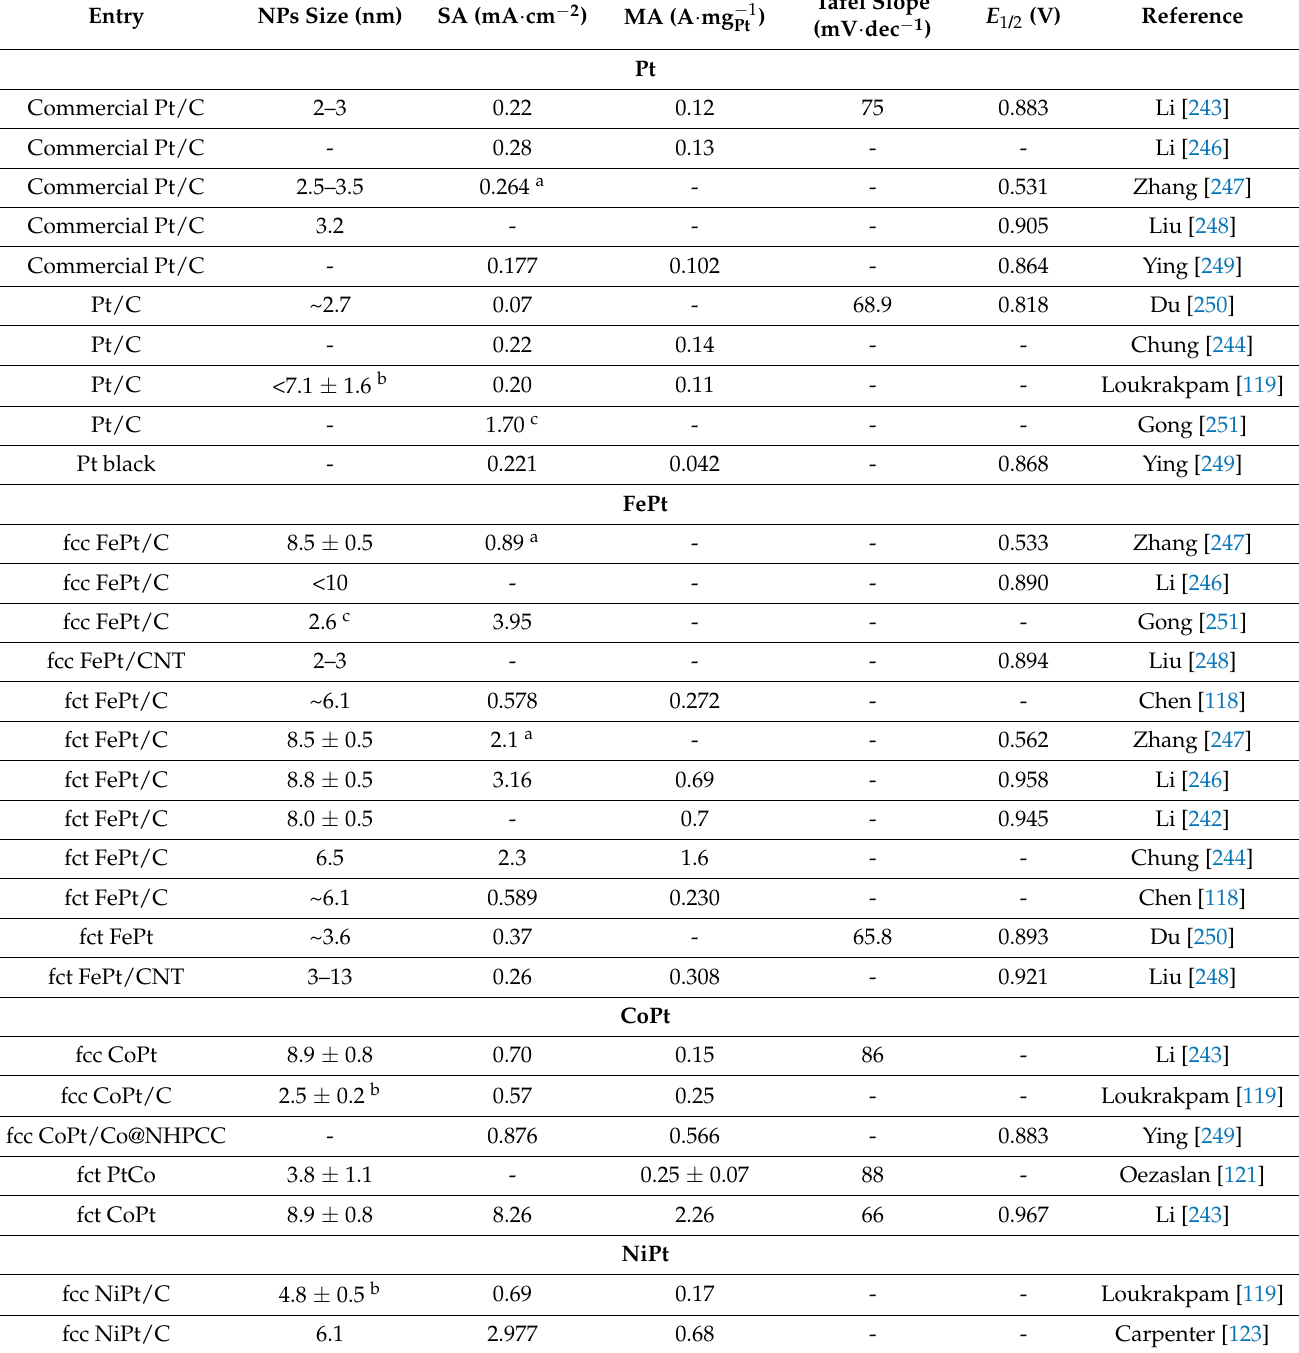
Table 3. Reported ORR catalytic performances of MPt (M = Fe, Co and Ni) NPs prepared by different methods in comparison with commercially available Pt catalysts. All the electrochemical measurements, half-wave potentials ( E 1/2 ), specific activity (SA), mass activity (MA) and Tafel slope were carried out in 0.1 M HClO 4 solution at room temperature, unless otherwise specified. SA and MA are measured at 0.9 V vs. RHE, unless otherwise